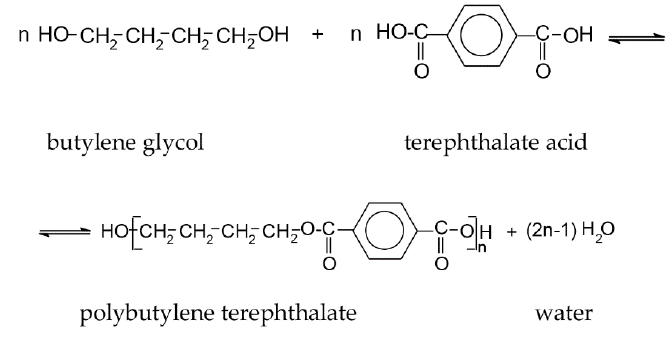
Figure 1. The chemical reaction for synthesis and structure of PBT polymer.